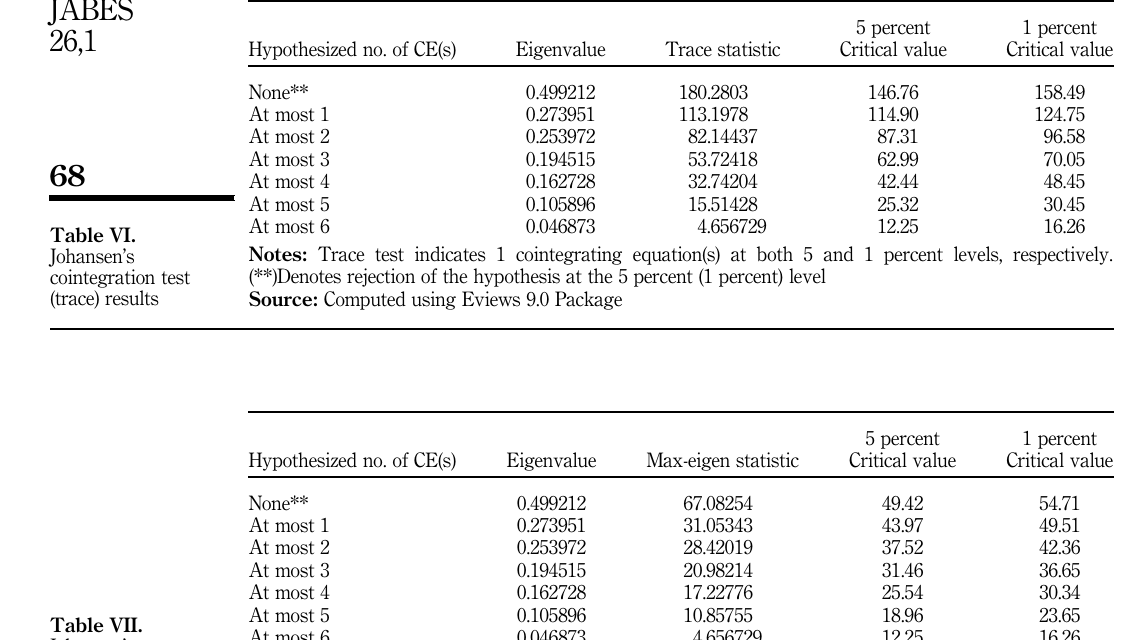
cointegration test